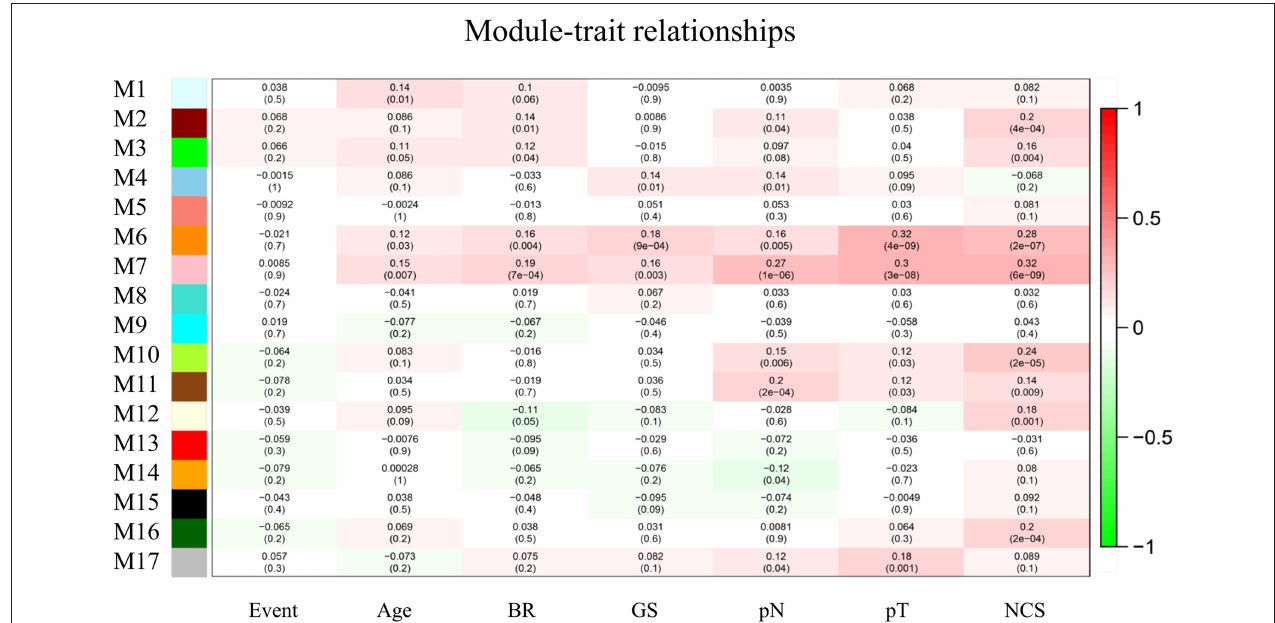
FIGURE 2 | Module–trait relationships. Each column corresponds to one trait, row to one module and every cell contains the correlation coefficient and p -value. The gray module represents genes not classified into any module. BR, biochemical recurrence. GS, Gleason score. pN, pathological N stage. pT, pathological T stage.